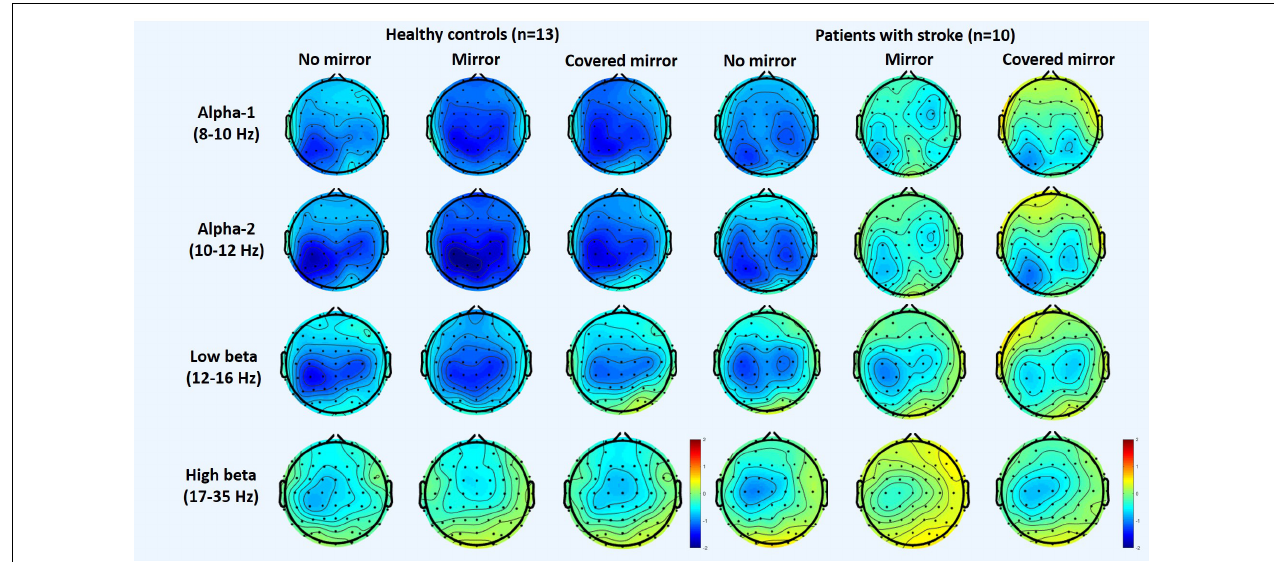
FIGURE 1 | Topography of the alpha and beta rhythms in three unimanual hand movement task conditions: with mirror, with no mirror, and with covered mirror, in two groups: stroke patients and healthy controls. TABLE 2 | The means and standard deviations of asymmetric index and ERSP power in each of the three task conditions in patients with stroke and health controls. Population Stroke patients Healthy controls Condition No mirror Mirror Covered mirror No mirror Mirror Covered